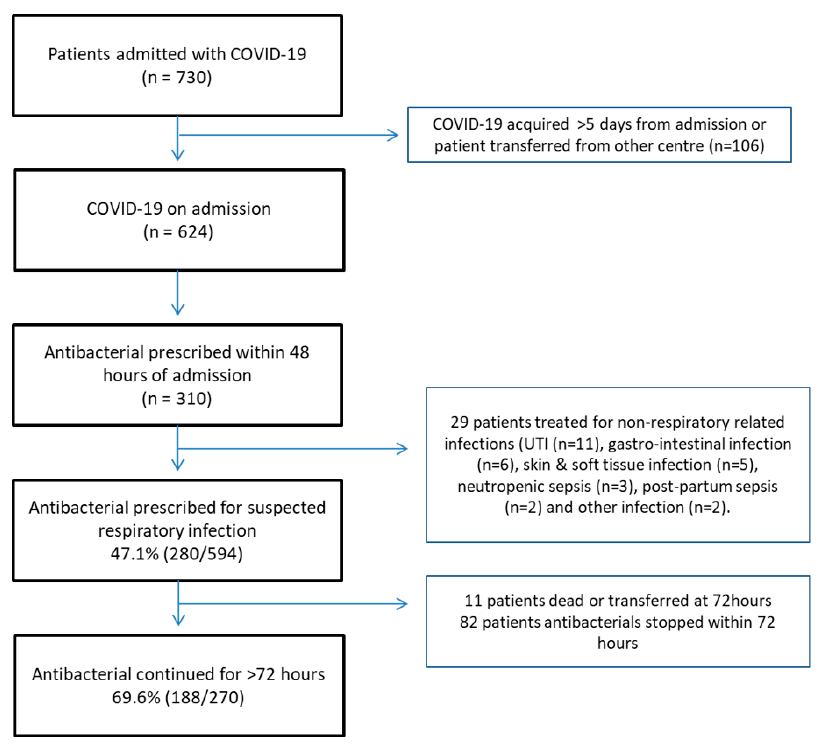
Figure 1. CONSORT diagram, associated of PCT and antibacterial prescription among COVID-19 patients, London, December 2020–February 2021 (UK wave 2).